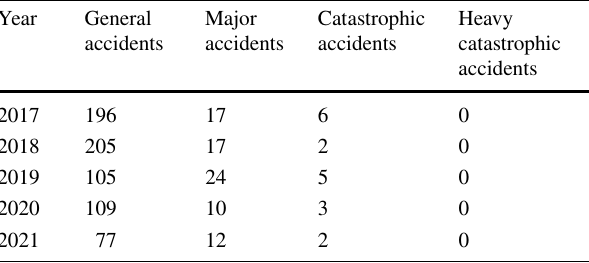
Table 1 Number of accidents in different levels from 2017 to